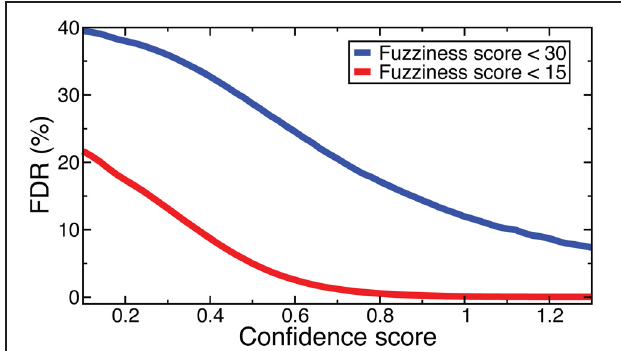
FIGURE 2 | FDRs computed from NOrMALÕs results using simulations described in text at fuzziness score thresholds 30 (blue) and 15